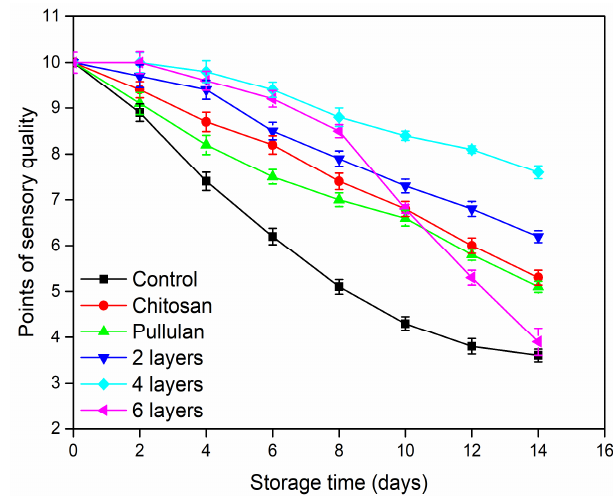
Figure 2. Sensory quality evaluation of papayas stored for 14 days at 25 °C, 50% RH. Scores below 5 mean that the papaya is not marketable. Vertical bars represent the standard errors of the means.